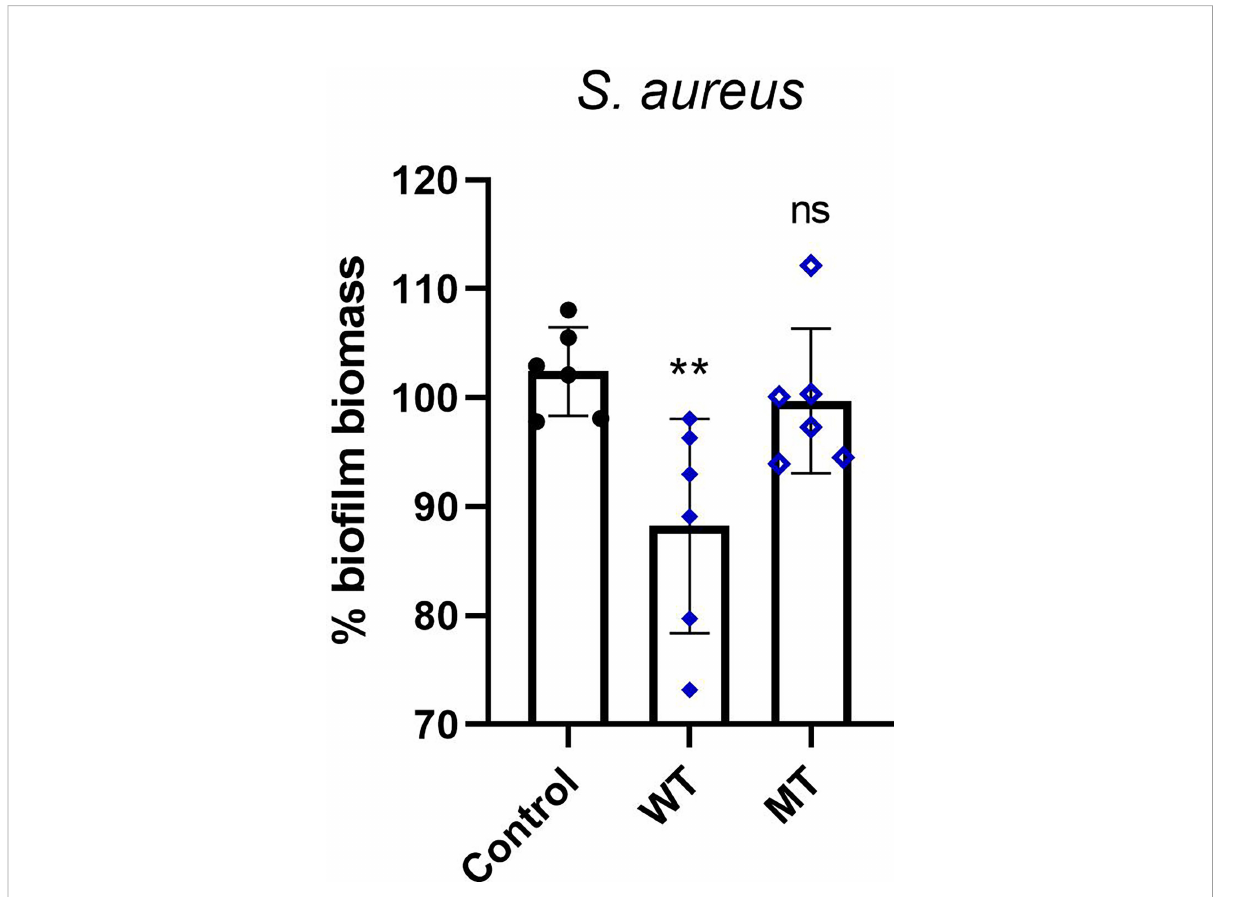
FIGURE 6 In vitro activity of DCD peptides AMPs against bio fi lm deposition. S. aureus (1 x 10 7 CFU/mL) was incubated with 2 µM of human DCD_WT or DCD_MT peptide in BHI medium containing 2% sucrose and plated on 96-multiwell plates for 24 hours. Cells were fi xed in methanol and stained with 0,1% crystal violet solution that was solubilised with 95% ethanol. The absorbance reads were measured at 560 nm using the GloMax ® Discover Microplate Reader (Promega). The low cut-off was represented by approximately 3 standard deviations above the absorbance mean of wells containing medium alone without bacteria. Results are represented as six independent experiments with 2 technical replicates each ±SD. Signi fi cant differences to control treatments were analysed by ordinary one-way analysis of variance (ANOVA) followed by Dunn ’ s multiple comparisons test (ns: non signi fi cant;